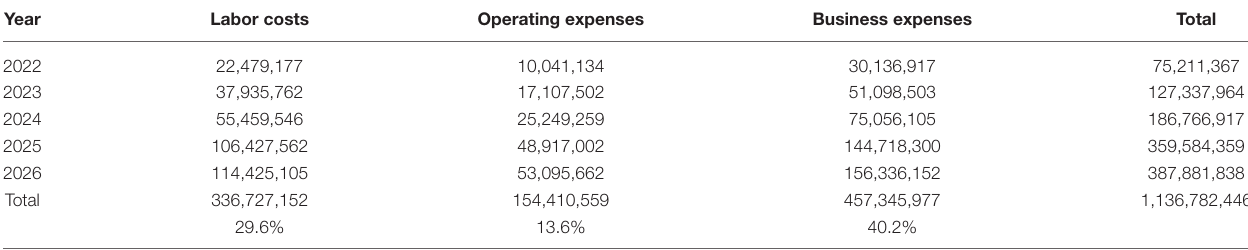
TABLE 9 | Estimated cost by item of integrated care for the elderly in the local community (overall).